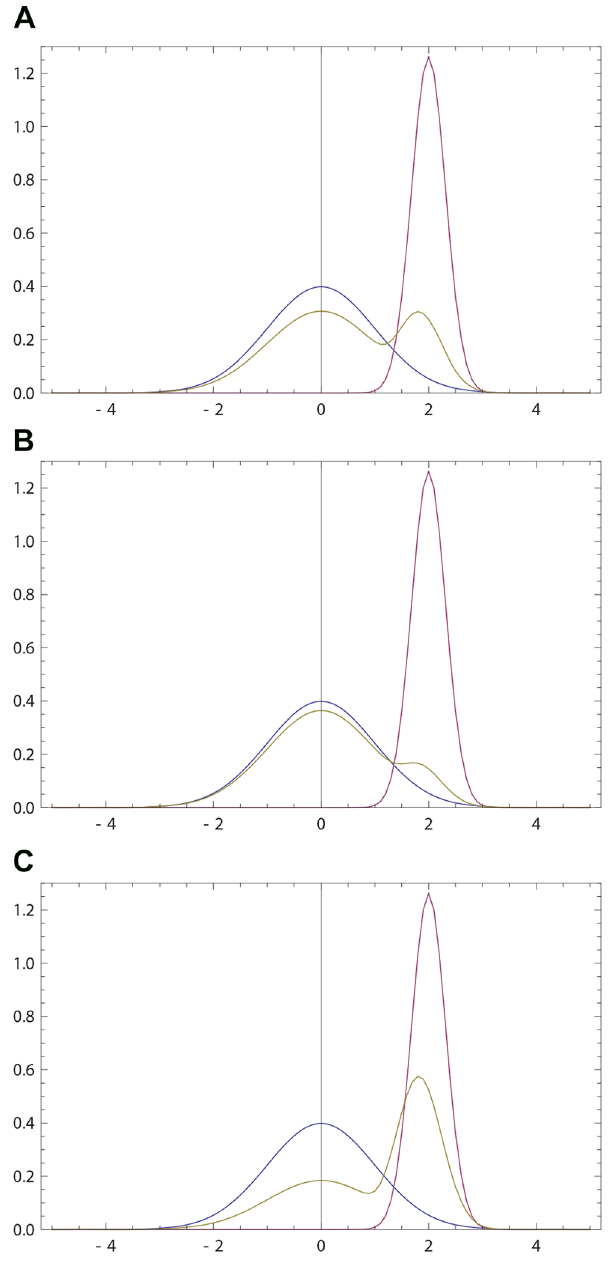
Figure 5. Cognitive dissonance. (a) Blue (resp. purple) curve: the initial opinion of agent P (resp. Q ) described by probability density p ( x ) (resp. q ( x )). Olive curve: the final opinion ~ pp ( x ) of P as given by (16) with E ~ 0 : 35 . Here p ( x ) and q ( x ) are defined by (17) with m P ~ 0 , v P ~ 1 , m Q ~ 2 , v Q ~ 0 : 1 . The final opinion develops two peaks of comparable height (cognitive dissonance). (b) Avoiding the cognitive dissonance due to a larger E ~ 0 : 75 : the second peak is much smaller (other parameters are those of (a)). (c) Avoiding the cognitive dissonance due to a smaller E ~ 0 : 05 : the first peak is much smaller (other parameters are those of